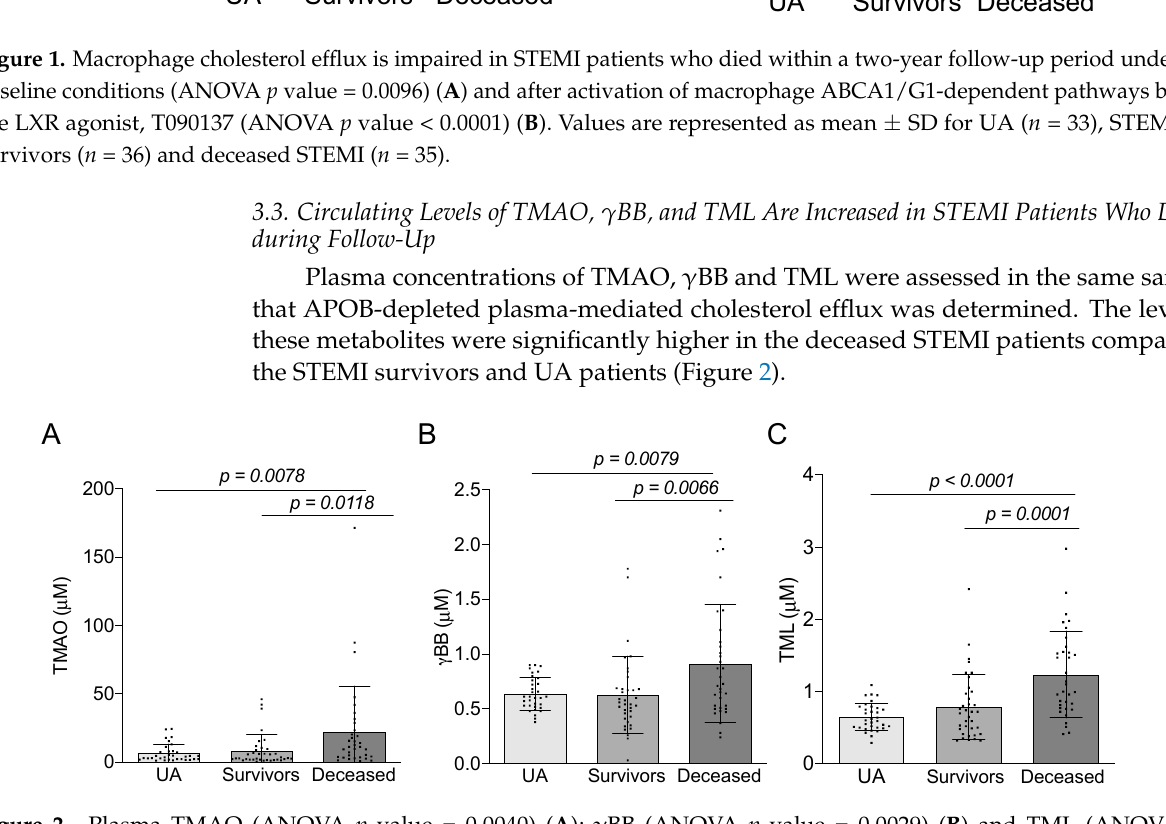
Figure 2. Plasma TMAO (ANOVA p value = 0.0040) ( A ); γ BB (ANOVA p value = 0.0029) ( B ) and TML (ANOVA p value < 0.0001) ( C ) levels were higher in deceased STEMI patients than in the other two groups. Values are represented as mean ± SD in UA patients ( n = 33), STEMI survivors ( n = 36), and deceased STEMI patients ( n = 35). We further evaluated the association between APOB-depleted plasma-mediated macrophage cholesterol efflux and mortality in these patients after adjusting for the main covariates that were significantly correlated with macrophage cholesterol efflux, including HDL-C, TMAO, and eGFR (all with p < 0.05). The association between the ABCA1/G1- mediated macrophage cholesterol efflux and death remained significant after adjusting for these parameters in (a) of (Table 2). However, both the baseline and ABCA1-mediated macrophage cholesterol efflux were not significantly associated with death following adjust- ment for these factors (Supplementary Materials Table S1). Furthermore, the ABCA1/G1- mediated macrophage cholesterol efflux association with death also remained